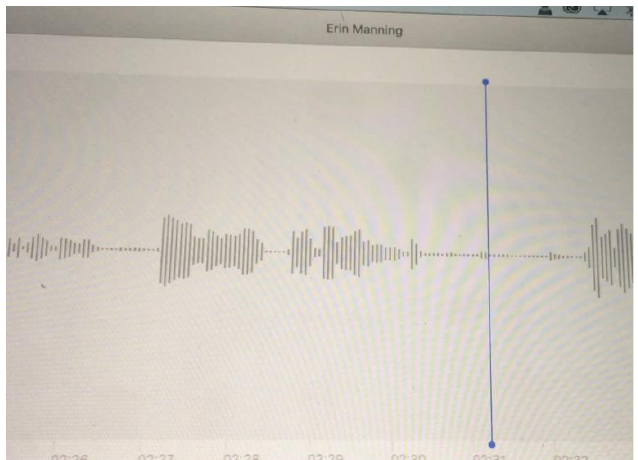
Figure 2 : Screenshot of video of memo clip as seen on my iphone The affective flows of these lines were mesmerising ... what had initially appeared to be empty space on the laptop screen was now energised by a pulsating field that was activated by the slippage between the respective device’s screen refreshing frequencies. It was through chance that what otherwise would have remained unseen became amplified. As the wave patterns filled the screen, I was struck by their uncanny resonances with Guattari’s notion of metamodelling as the excess of the model, of all that escapes the model. As Manning writes: For Guattari, metamodeling draws schizoanlaytic diagrams of life-living, diagrams that are always more than a passage from here to there, diagrams thick with the resonance of orientations fabulated, of turns not taken, languages unscripted. Metamodeling feels